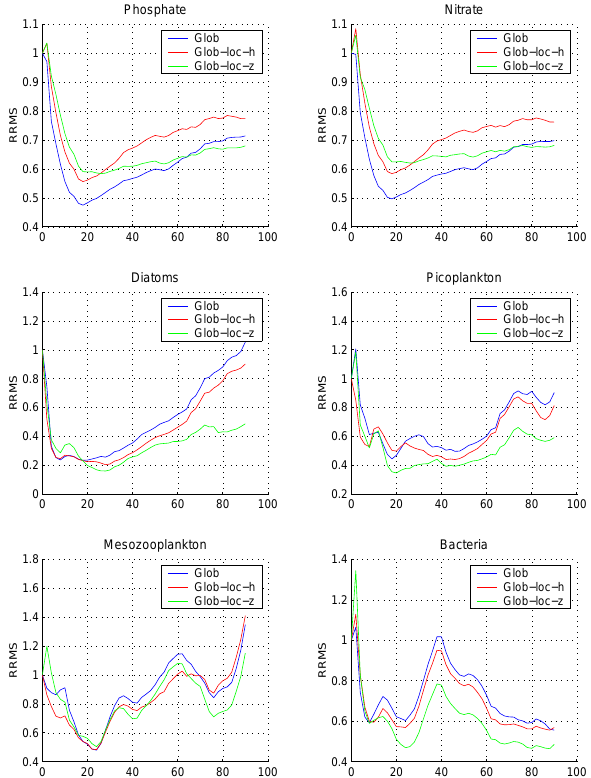
Fig. 6. Evolution in time of phosphate, nitrate, diatoms, picoplank- ton, mesozooplankton and bacteria RRMS from the SFEK/SFPLEK filter assimilating profiles using global EOFs (SFEK filter), global- local EOFs (SFPLEK filter), from 3 horizontal and 3 vertical sub- domains (as shown in Fig